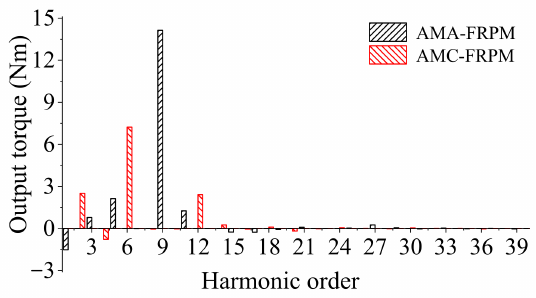
Figure 15. Contributions of the air-gap harmonics to the torque in the two AM-FRPM machines.